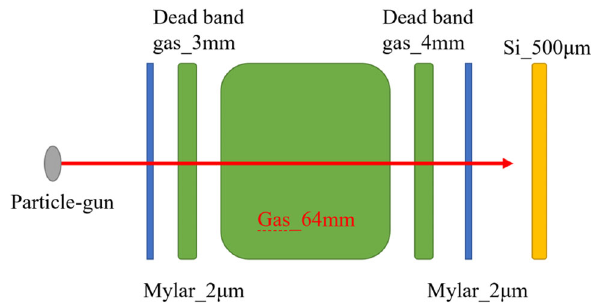
Fig. 12 Simulation geometry setup model in